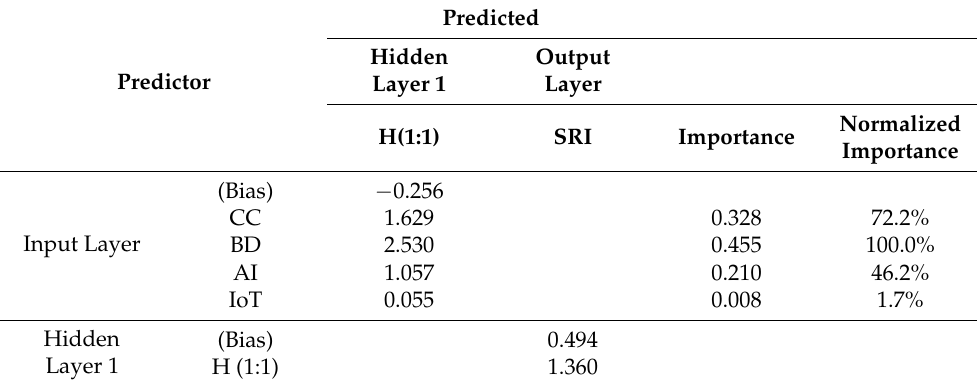
Table 3. Predictors of the MLP model.